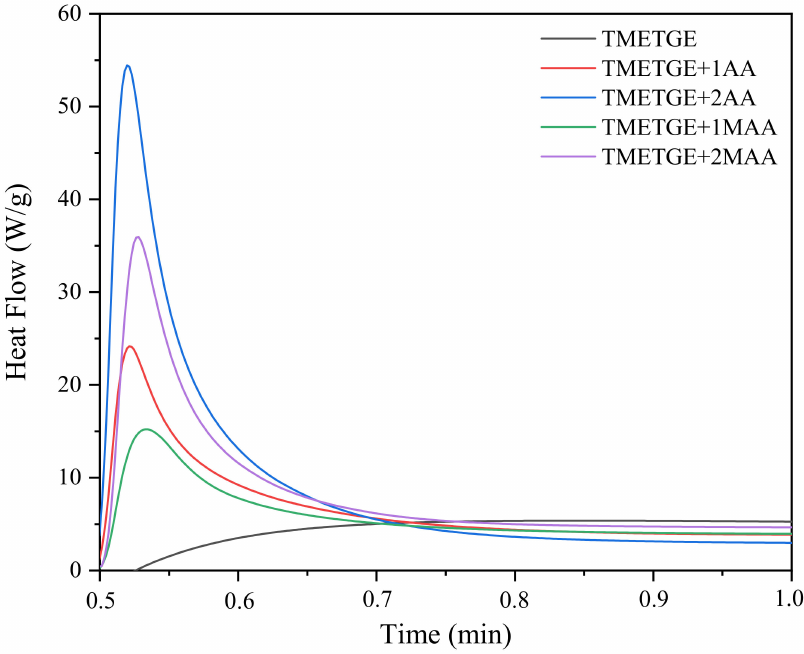
Figure 10. Photo-DSC exotherms for the photopolymerization of epoxy (meth)acrylate formulations with radical